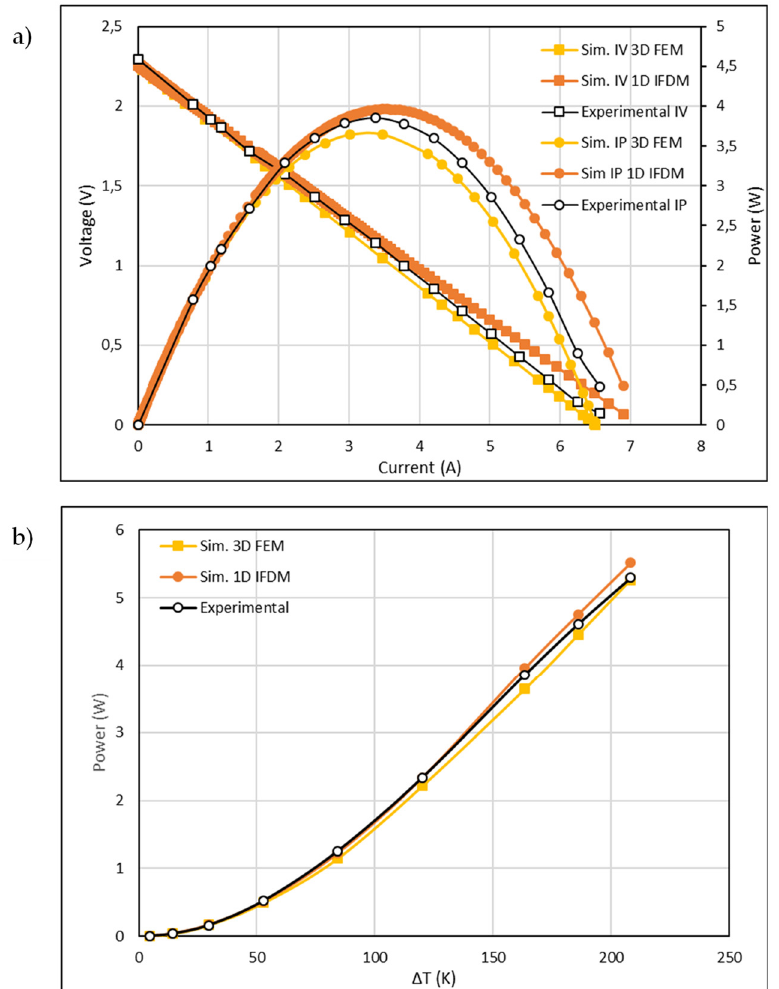
Figure 4. ( a ) Typical IV and IP curves for the maximum power obtained when the sink ∆ T was 163 K, and ( b ) power vs. temperature difference (heat source and sinks) for the GM200 simulated and tested in the experimental set up.